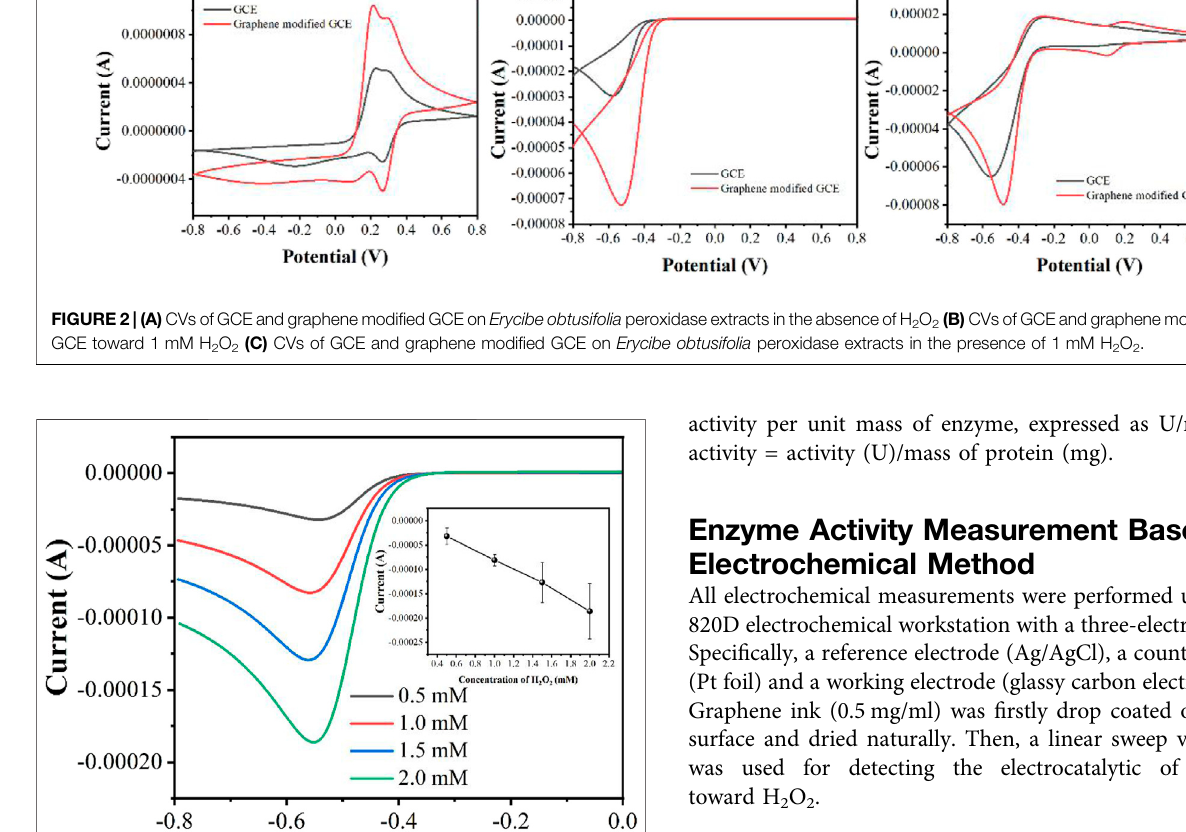
Frontiers in Chemistry |